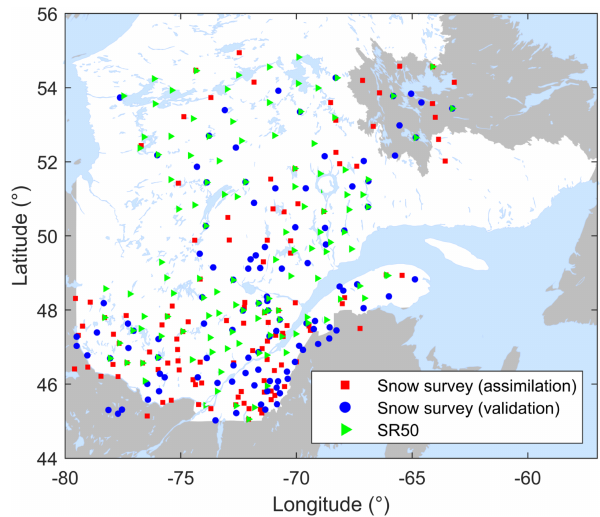
Figure 1. Snow observation sites in and around Quebec